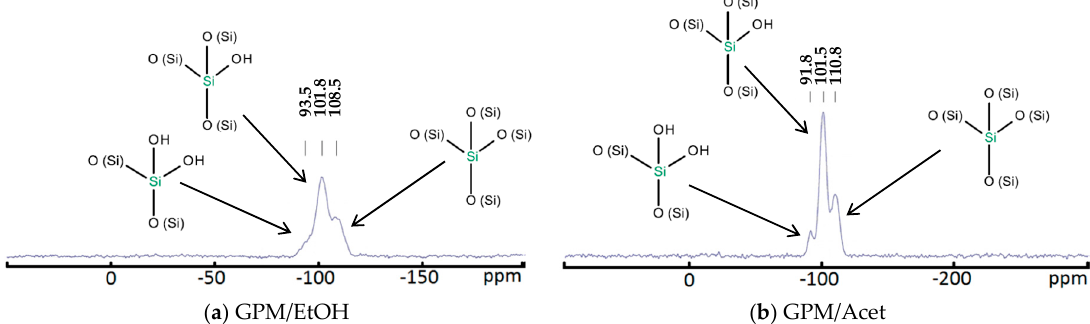
Figure 1. 29 Si NMR spectra of the synthesized powders: ( a ) GPM/EtOH and ( b ) GPM/Acet.